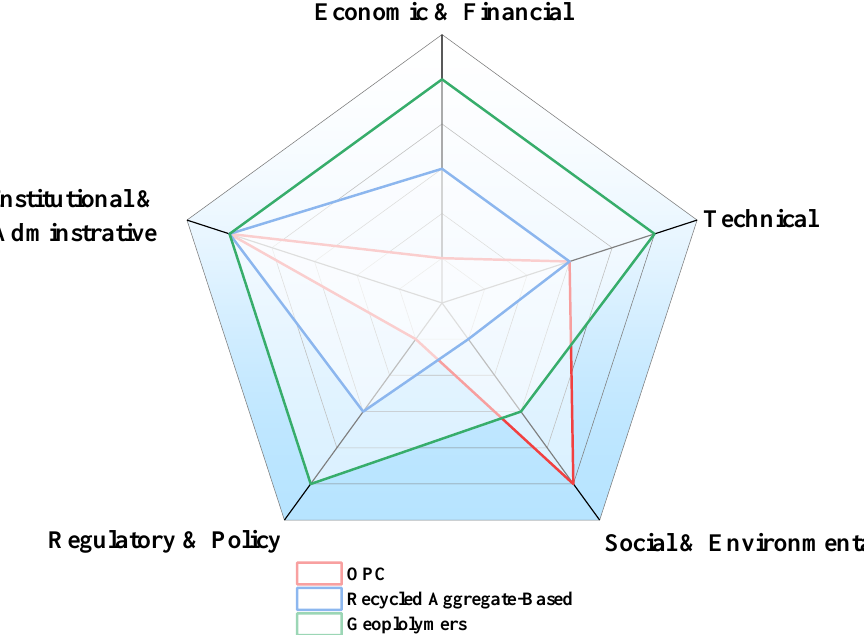
Figure 4. Comparison of Degree of Limitations between Conventional Construction and 3DCP.